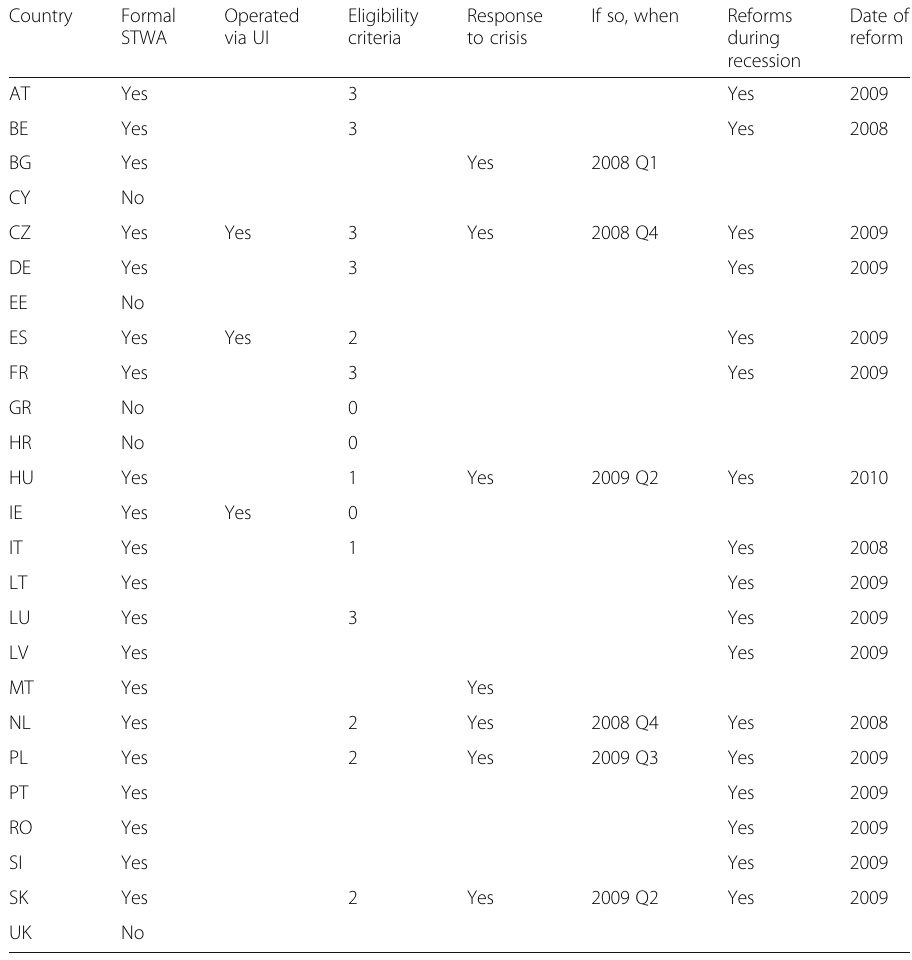
Table 2 Taxonomy of STW schemes Country Formal